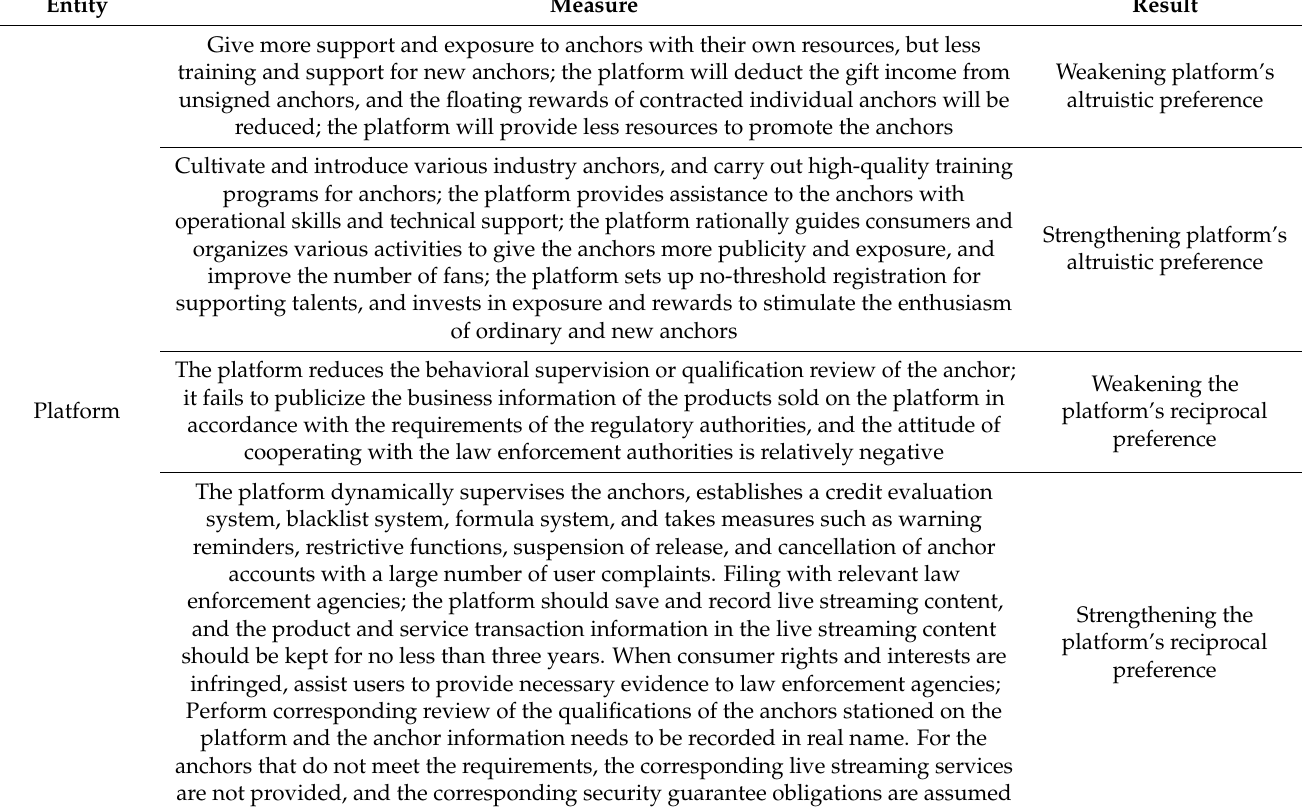
Table 10. Platform–anchor–consumer governance measures in the transaction stage of live streaming governance.